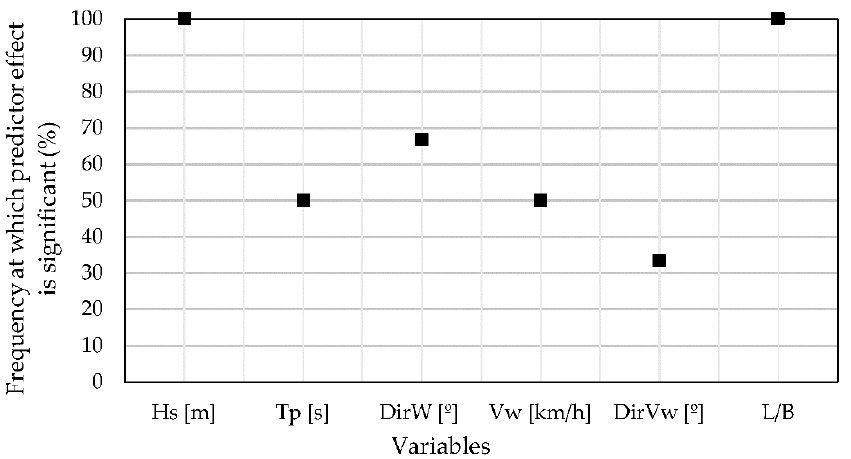
Figure 7. The relative frequency corresponding to the models where the effect of each predictor on the response is significantly different from zero.